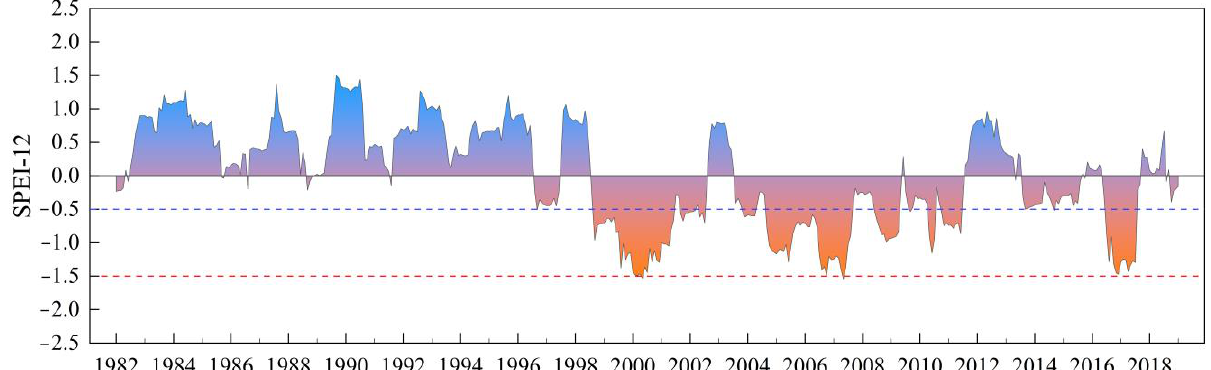
Figure 9. SPEI-12 fluctuations in Inner Mongolia. The gradient color block represents the change of SPEI-12. Blue indicates wetting and orange indicates aridity. The blue dotted line indicates an SPEI value of -0.5, which is the boundary between drought conditions and non-drought conditions. The red dotted line indicates severe drought.